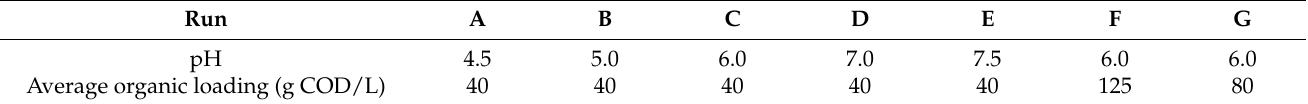
Table 2. Presentation of the tested runs under several pH and organic loading values.